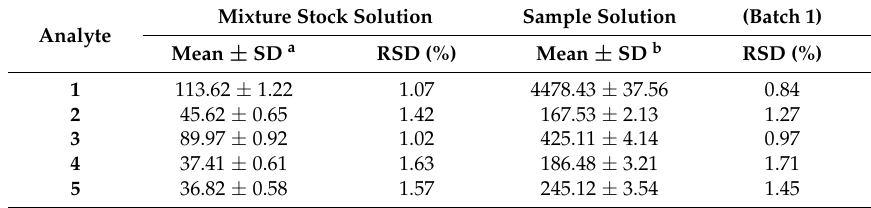
Table 4. Stability of mixture stock solution and sample solution stored at 20–25 ◦ C for 3